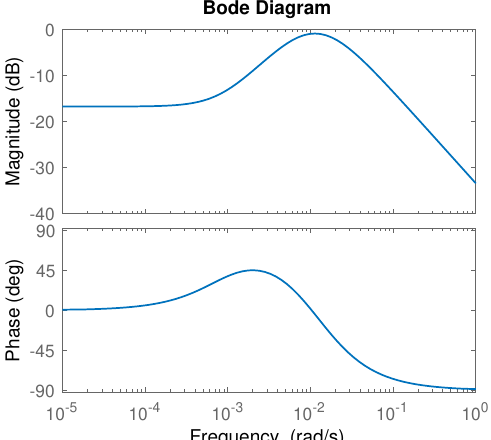
Figure 9. Bode diagram of WC (cid:101) S for K p = 2 and K i = 0.004 considering multiplicative uncertainty.